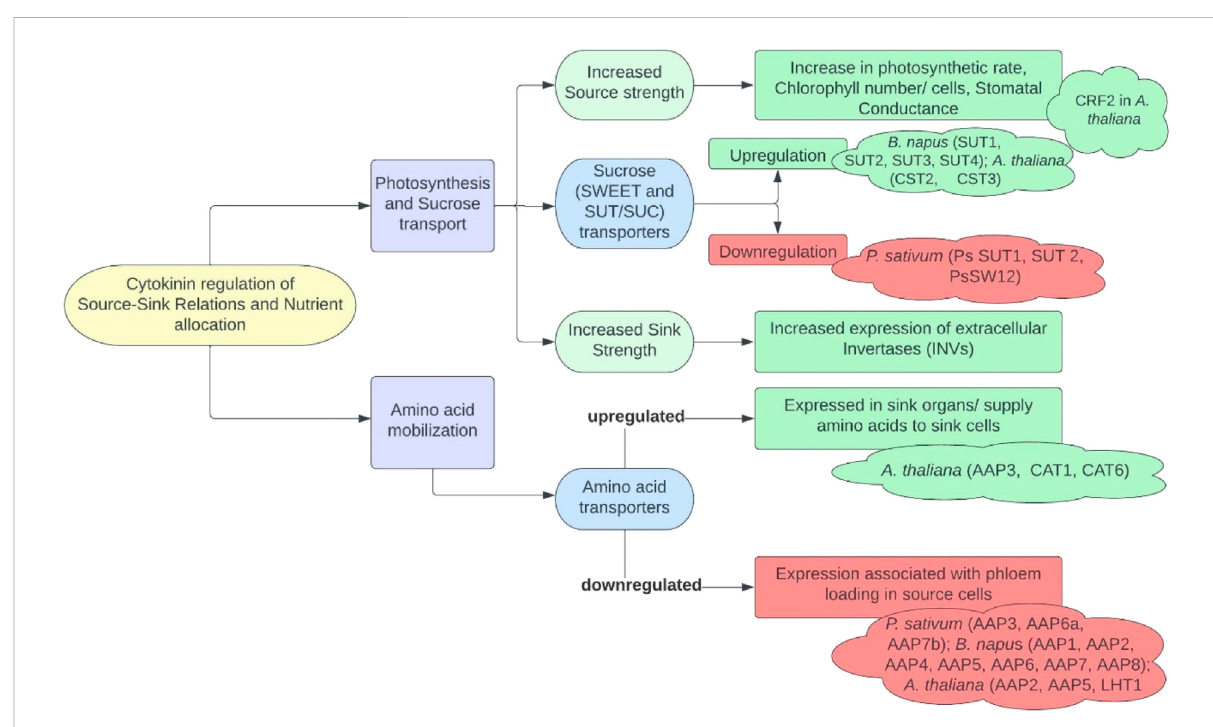
FIGURE 3 Insights into cytokinin-mediated source-sink relationship and nutrient allocation (SWEET, SUGARS WILL EVENTUALLY be EXPORTED TRANSPORTERS;SUT/SUCs,SUCROSETRANSPORTERS/CARRIERS; AAP ,aminoacidpermease; LHT ,lysineandhistidinetransporters; CAT ,cationic amino acid transporters) (for references, see McIntyre et al., 2021; Harms et al., 1994; Ninan et al., 2017; Song et al., 2015; Ehness and Roitsch, 1997; Godt and Roitsch, 1997; Yang et al., 2014; Chernyad ’ ev, 2000; Ahanger et al., 2020; Boasson and Laetsch, 1969; Okazaki et al., 2009; Lee et al., 2007; Kiba et al., 2011; Kiba et al., 2005; Yokoyama et al., 2007; and Jian et al.,